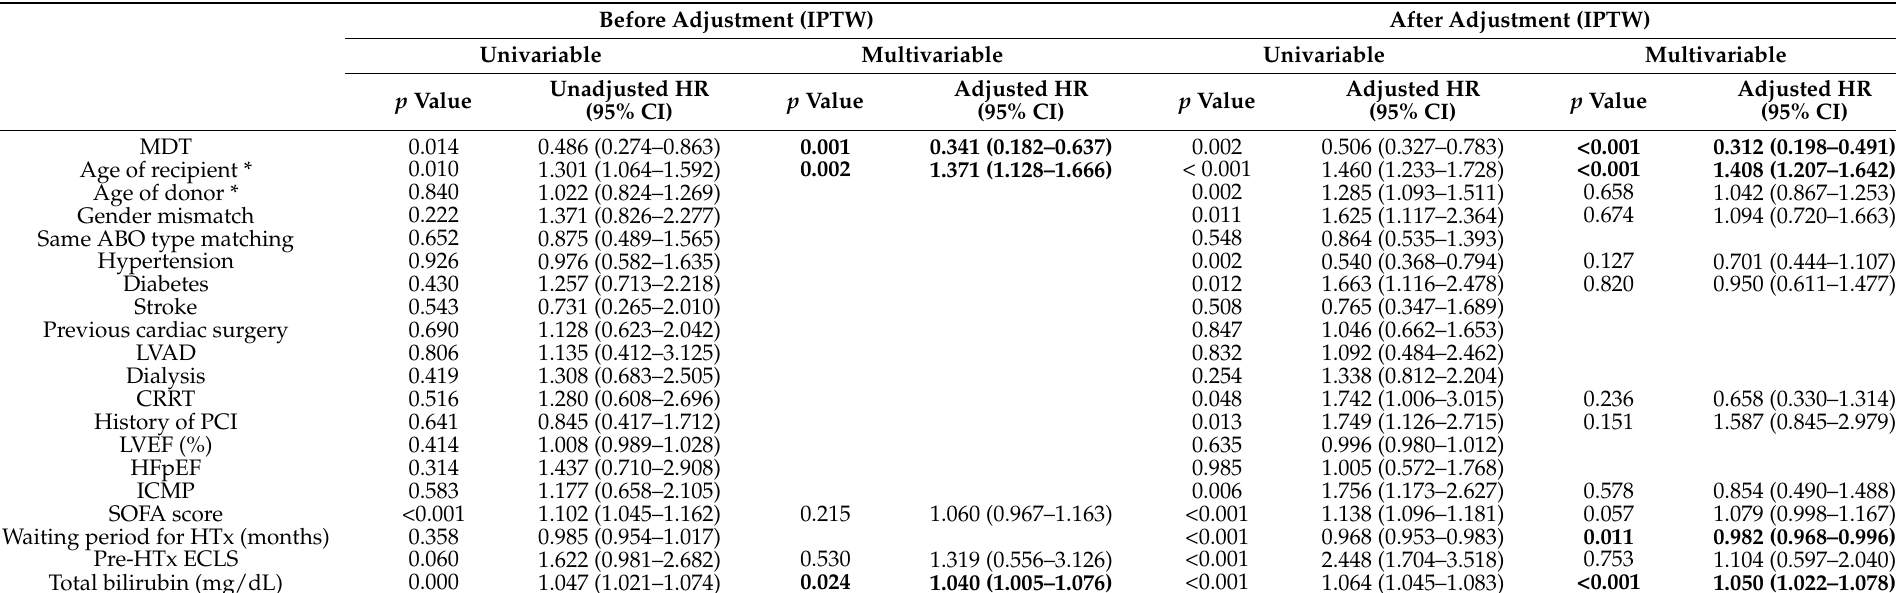
Table A3. Predictors of overall